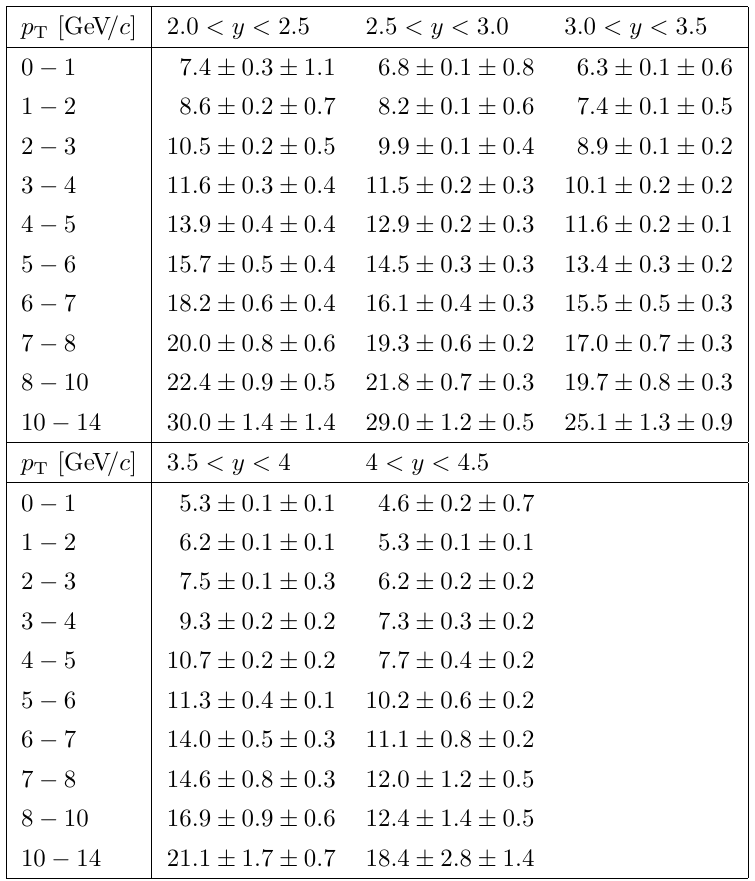
Table 8 . Fraction of nonprompt J/ψ mesons (in %) in ( p T , y ) intervals. The first uncertainty is statistical and the second is